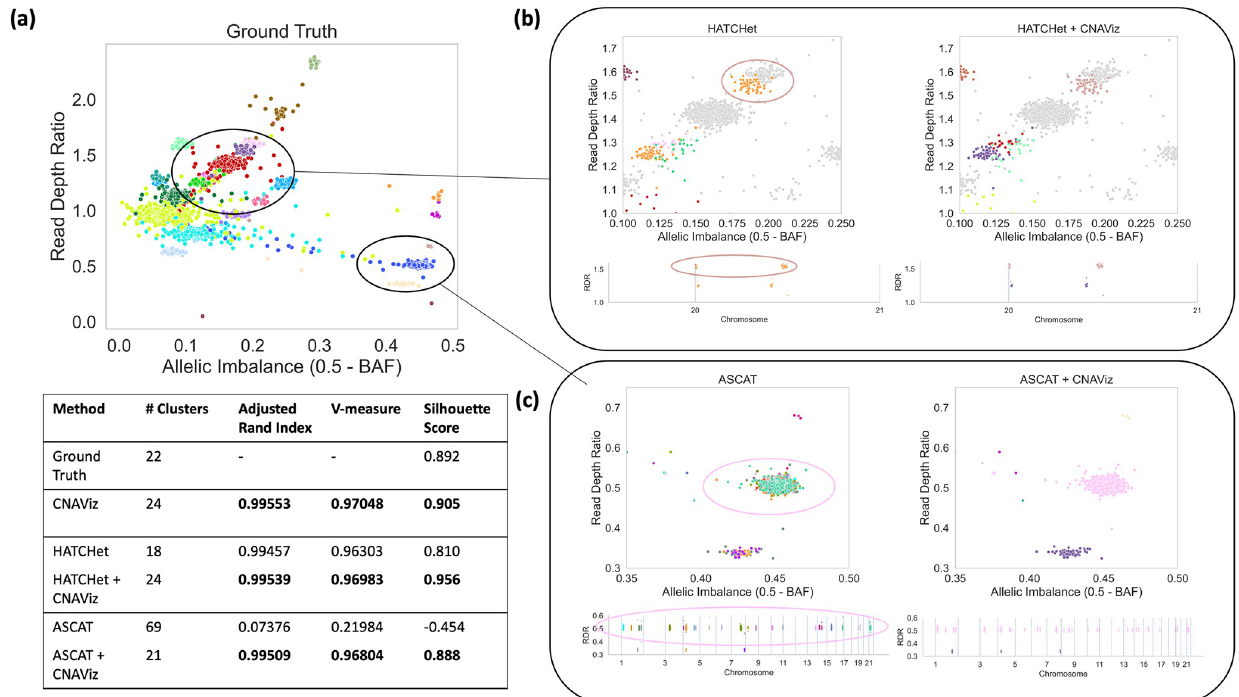
Fig 4. By using CNAViz, users are able to produce more accurate segmentation solutions on simulated data in both de novo mode as well as when refining a given segmentation. (a) A two-dimensional plot of RDR ( y -axis) and allelic imbalance ( x -axis, measured as 0.5 − BAF) of 50 Kb genomic bins (points). Colors represent the ground-truth segments/clusters. Table shows performance metrics for each method. (b) Comparison of HATCHet’s global segmentation solution before (left plots) and after user refinement (HATCHet + CNAV IZ , right plots). (c) Comparison of ASCAT’s local segmentation solution before (left plots) and after user refinement (HATCHet + CNAV IZ , right plots). In each plot of (b) of (c) respectively, the same genomic bins are displayed, but colored according to each method’s inferred segmentation.